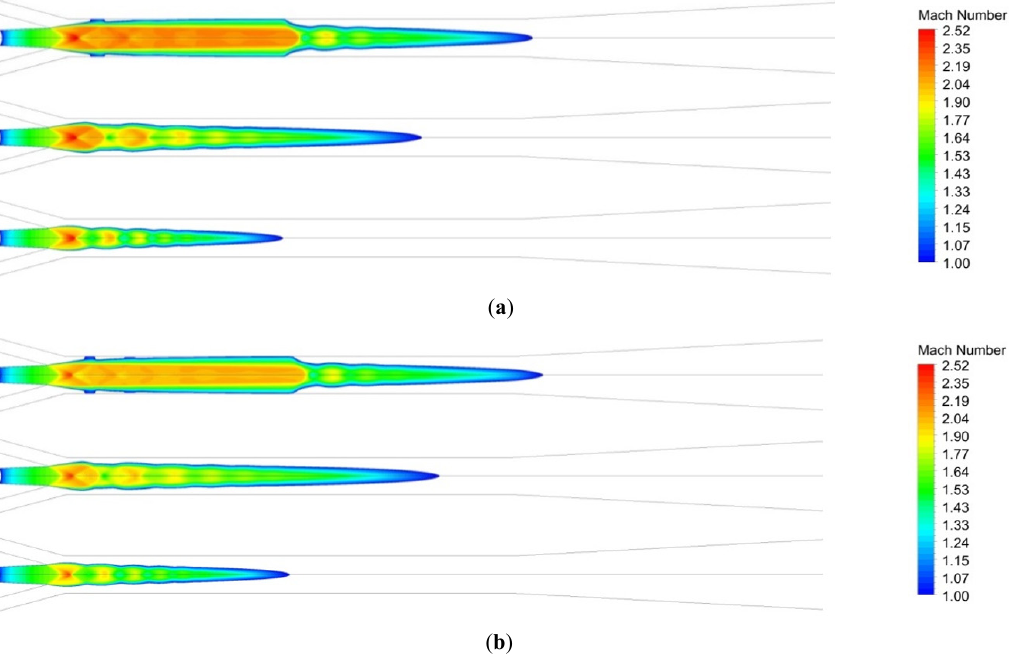
Figure 7. Mach number contours with different back pressure inside ejector baseline given T p = 80 °C, T s = 10°C for: ( a ) R1234ze(E) at P c = 600, 613, 645 kPa respectively from top to bottom. ( b ) R1234yf at P c = 780, 801, 840 kPa, respectively from top to bottom.